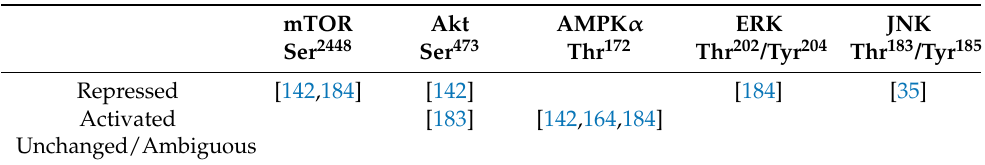
Table 2. Overview of the included publications studying signal transduction pathways in ani- mal models.